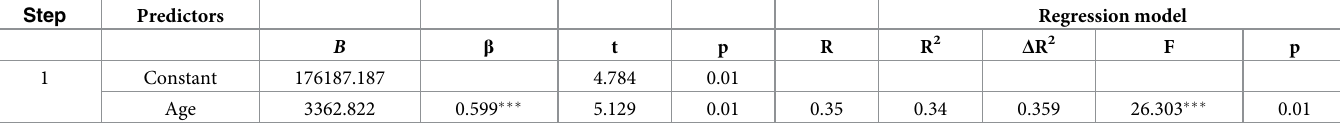
Table 2. Stepwise multiple linear regression analysis of difficulties in emotion regulation, depression, anxiety, age, the pain index scales and control variables on total performance times in the attention task.